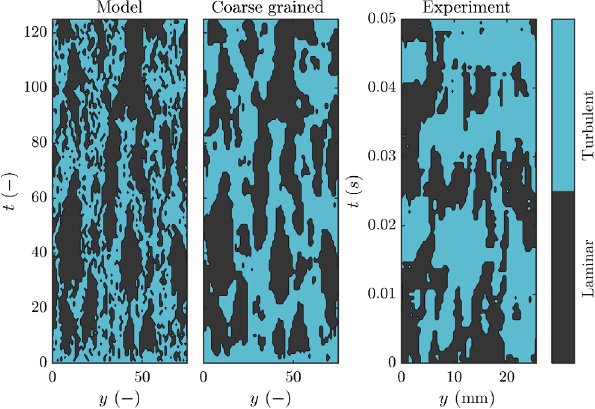
FIG. 9. Illustrations of cluster distributions in time and space at criticality. In the right diagram, a typical snapshot obtained from the experimental HSPIV data is depicted. In the left diagram, the (detailed) result from a DP simulation is compared with the corresponding coarse-grained